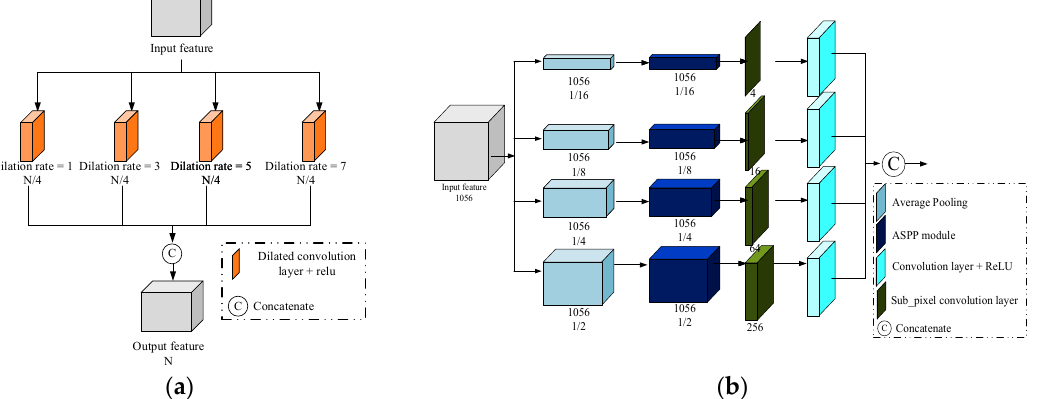
Figure 3. Sub-modules in the network. ( a ) The atrous spatial pyramid pooling (ASPP) module. ( b ) The multi-scale